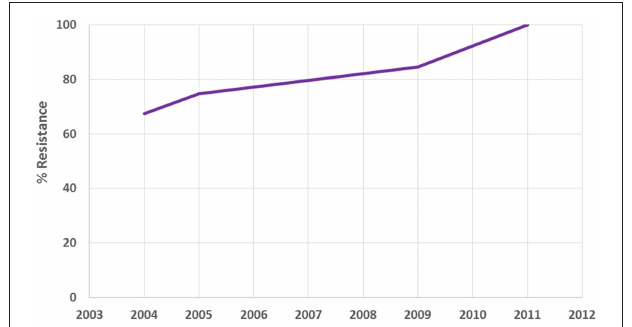
FIGURE 2 | Sample antibiotic resistance data from the cities of Karaganda (Kazakhstan) and Tbilisi (Georgia). The chart shows resistance of Pseudomonas aeruginosa to Ciprofloxacin.